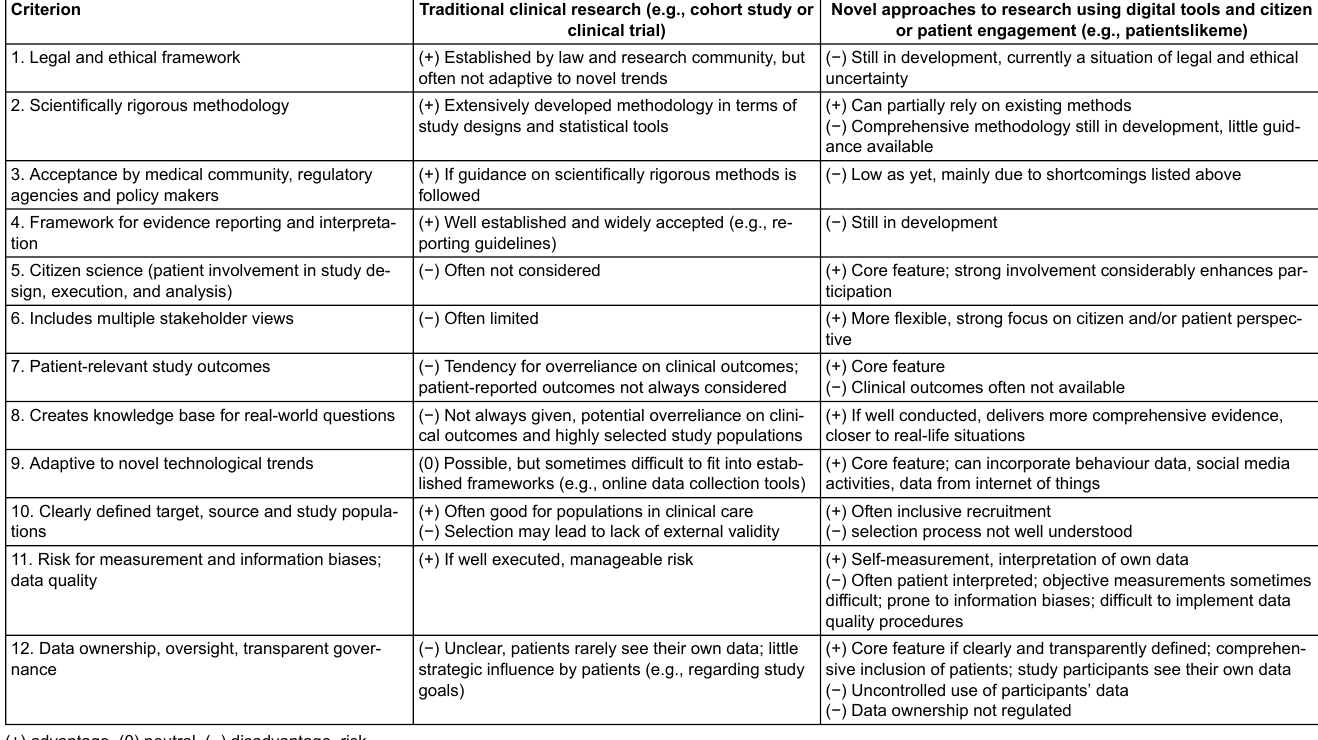
Table 1: Advantages and disadvantages of traditional medical research, and opportunities and risks of novel approaches using societal and technological developments.